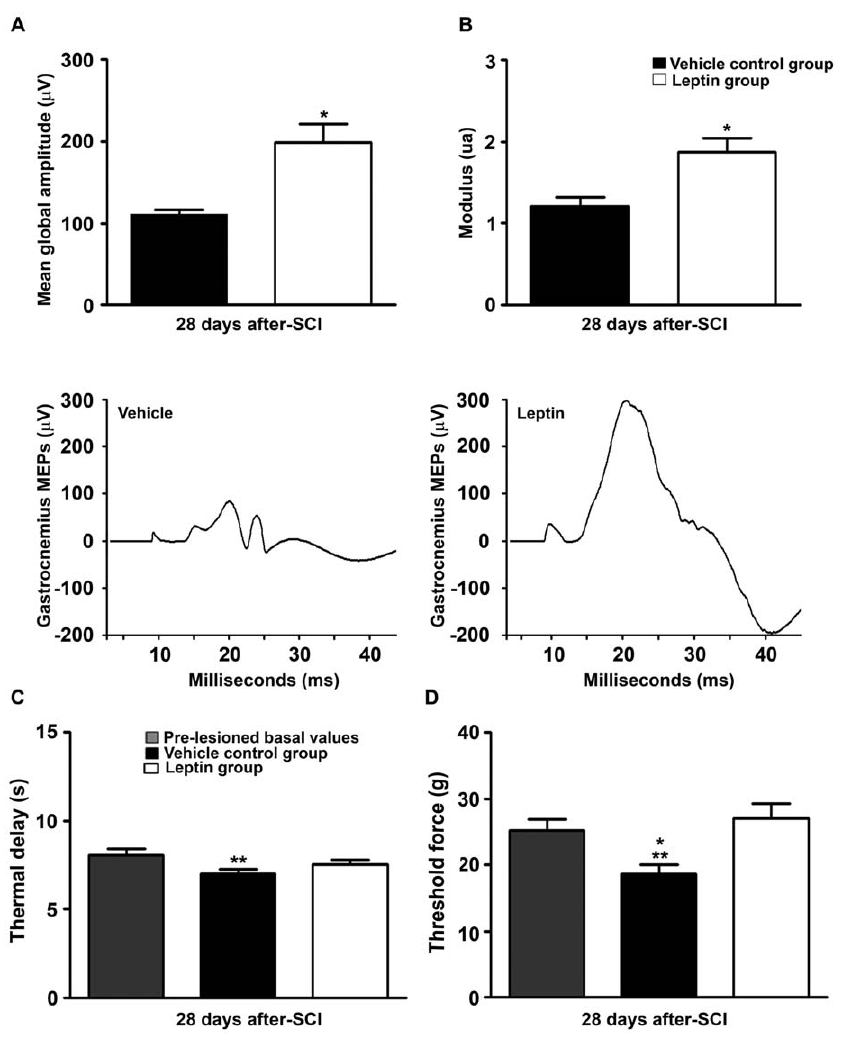
Figure 7. Electrophysiological assessment and neuropathic pain. Electrophysiological tests were carried out at 28 d post-SCI to analyse the motor evoked potentials (MEPs). Leptin administration significantly increased the average maximum amplitude (A) and rectified area under the curve (B) when compared with vehicle-treated controls. (C and D) At 28 d post-SCI, vehicle-treated controls exhibited a significant decrease in paw withdrawal latency when compared with the basal values determined in pre-lesioned conditions, indicative of thermal hyperalgesia. Leptin administration had no effect on the thermal delay when compared with the basal values determined in pre-lesioned conditions, indicating an attenuation of neuropathic pain. In terms of nociception, we observed similar mean latencies of heat-induced paw withdrawal in leptin-treated animals when compared with pre-lesioned conditions (8.01 6 0.36 seconds), while a significant decrease in latency was observed in the vehicle control group (6.84 6 0.25 seconds). Similarly, mechanical stimulation with Von-Frey filaments required a significantly lower mean threshold force to induce hind paw retraction in the vehicle control group (18 6 2.1 grams) following SCI when compared with the basal values determined in pre- lesioned conditions (25 6 1.67 grams); however, there were no such differences in leptin-treated animals (D). The values in A–D represent the mean 6 SEM. A and B; * p , 0.0025 versus the vehicle-treated controls. C and D; ** p , 0.05 versus the basal values in pre-lesioned conditions; * p , 0.05 versus the vehicle-treated